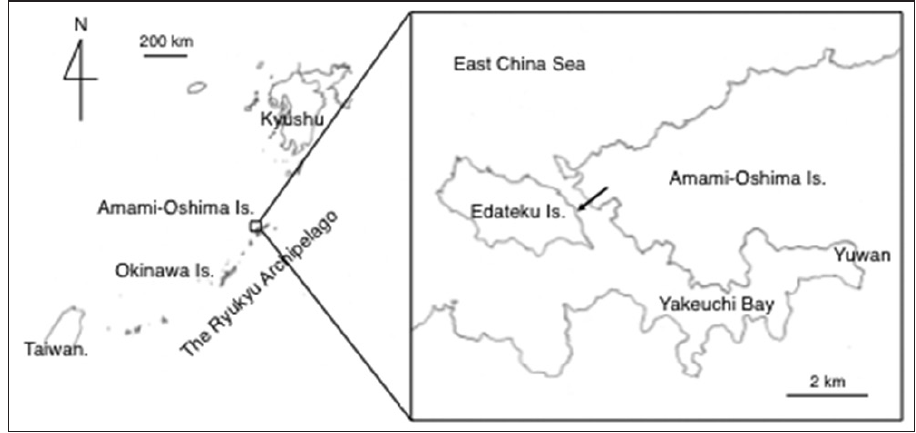
Figure 1. The locality of Pharaonella amanyu sp. n. in the Amami Islands, Ryukyu Archipelago. The sand flat constituting the type locality of this new species is shown by an